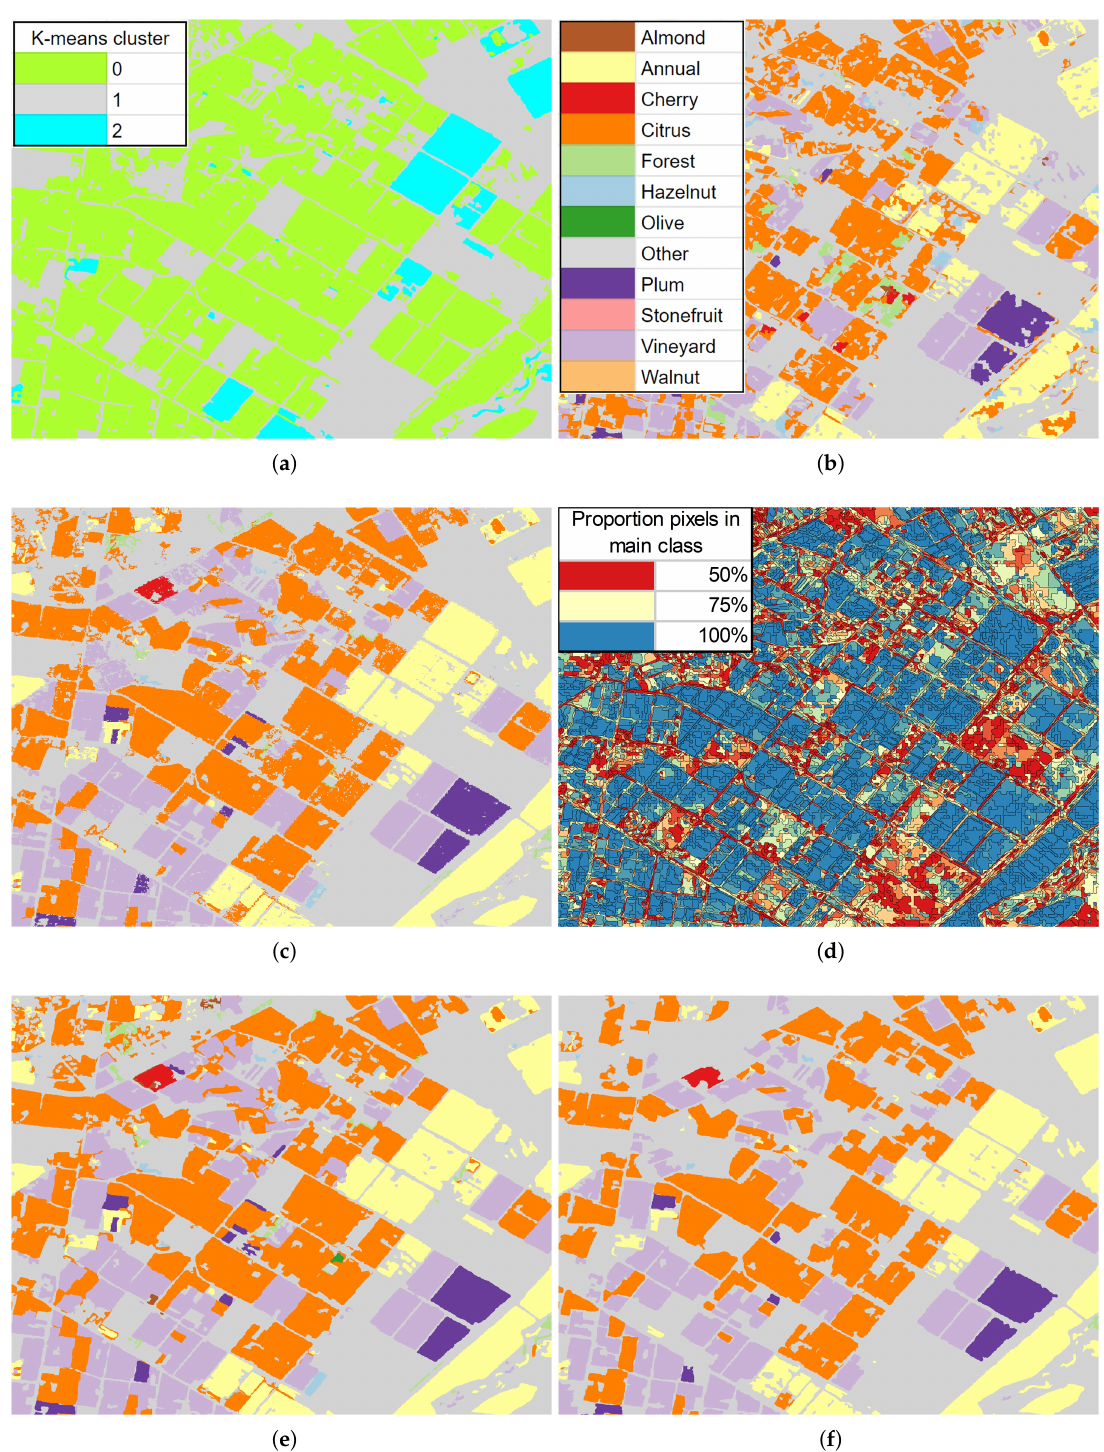
Figure 13. Example 33 km 2 area of the classified maps. ( a ) K-means clustering with k = 3. ( b ) Object-based classified map using S1 radar time series (TS). ( c ) Pixel-based classification using S2(10) + S1(2) TS. ( d ) Proportion of pixels belonging to the majority class within each segment. ( e ) Refined object-based map using S2(10) + S1(2) TS features with proportion threshold of 0%. ( f ) Refined object-based map using S2(10) + S1(2) TS features with proportion threshold of